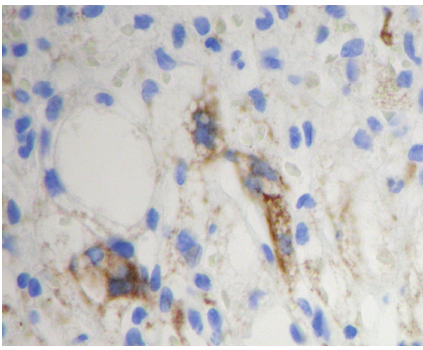
Figure 3: Inhibin immunohistochemistry was positive in scattered tumor cells throughout the neoplasm ( ×